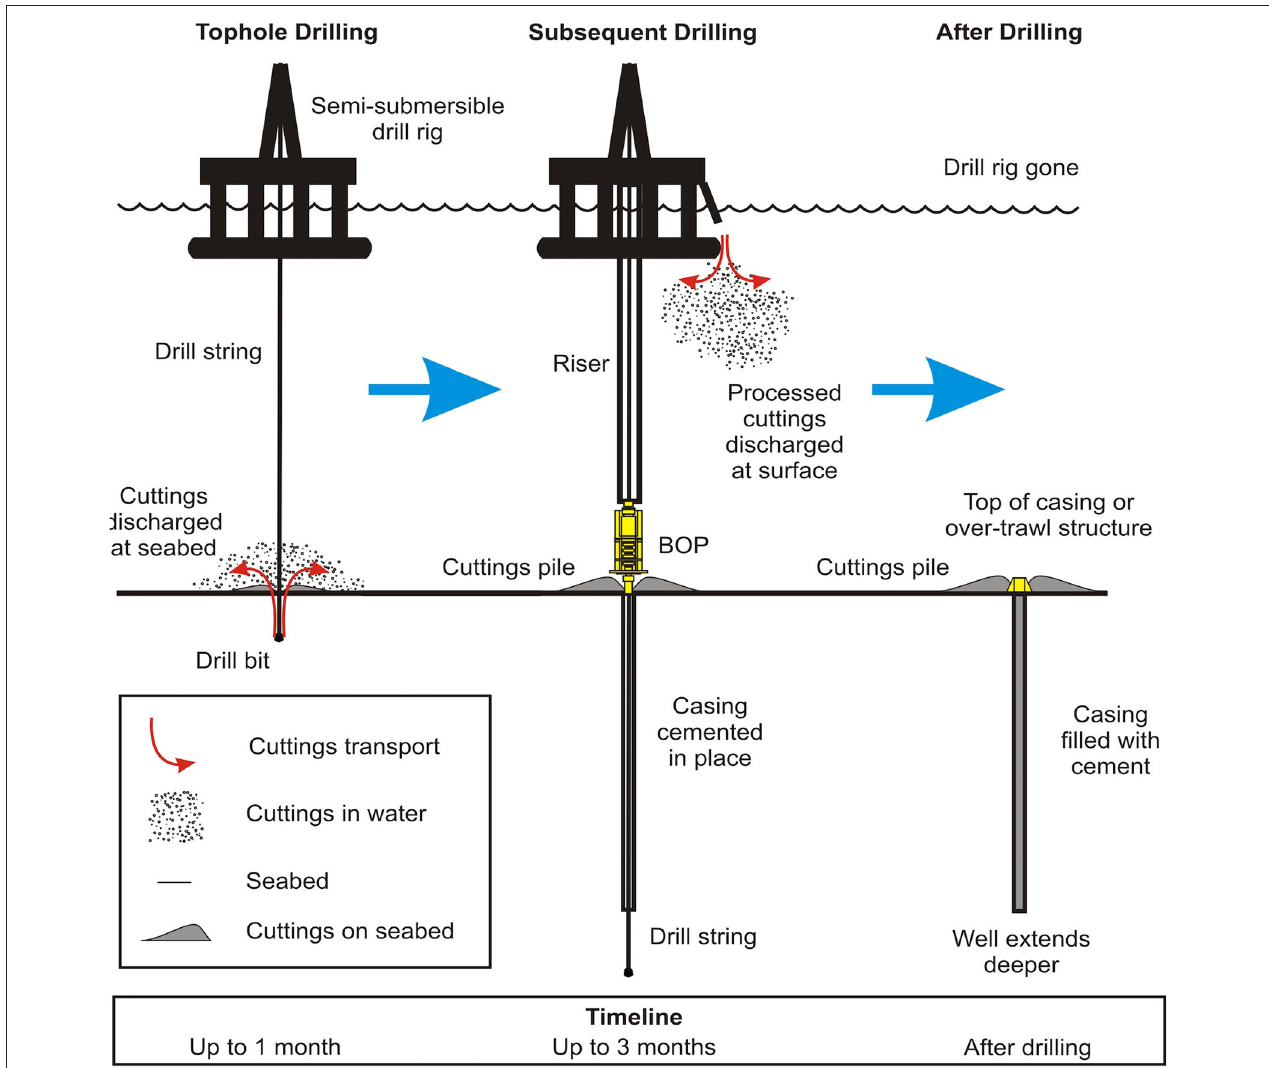
FIGURE 2 | Primary sediment discharges made during exploration drilling activity in deepwater. These effects are nearly identical whether a semi-submersible rig (as shown) or a drillship is used for